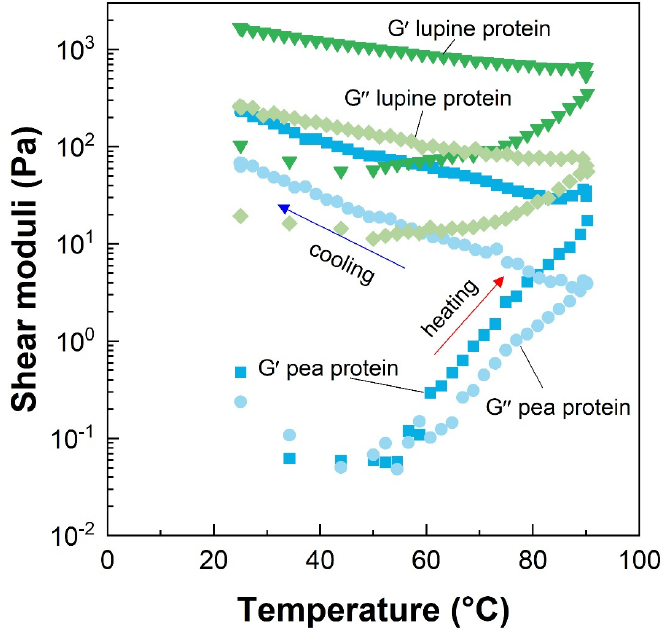
Figure 2. Temperature sweep in a parallel plate from 25 °C to 90 °C at a heating rate of 5 °C min − 1 of pea (12.5 %) and lupine (15 %) protein dispersions at γ = 0.1% and f = 1 Hz.